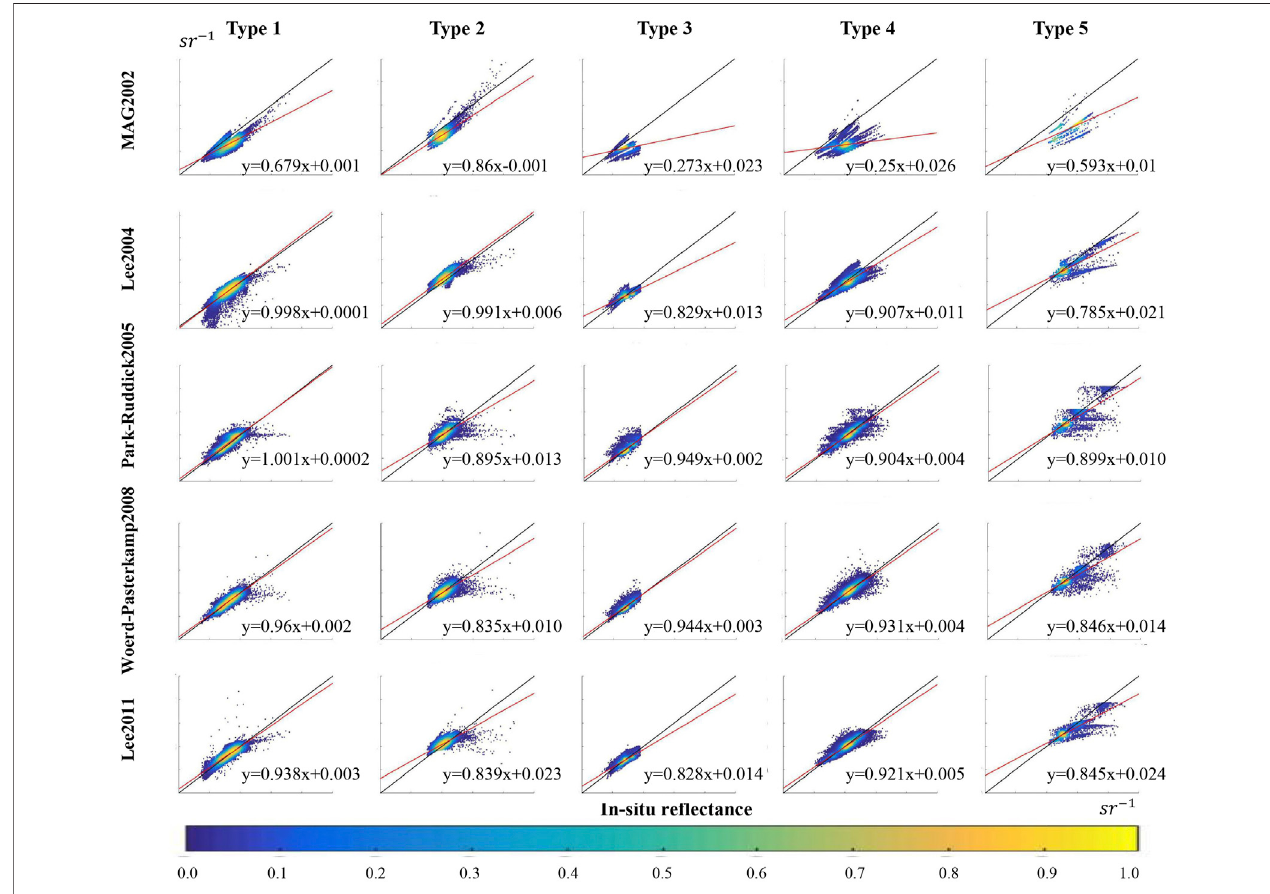
FIGURE6| Scatterdensityplotsof fi vemodelsimulationsandmeasurementsconductedattheGreenBandfor fi vewatertypes.Thevaluesarepresentedatlinear scales. The solid red color lines in the fi gures are the fi tting lines. The solid black lines are the reference lines of 1:1. The ranges of x -axis and y -axis are both 0 – 0.15.